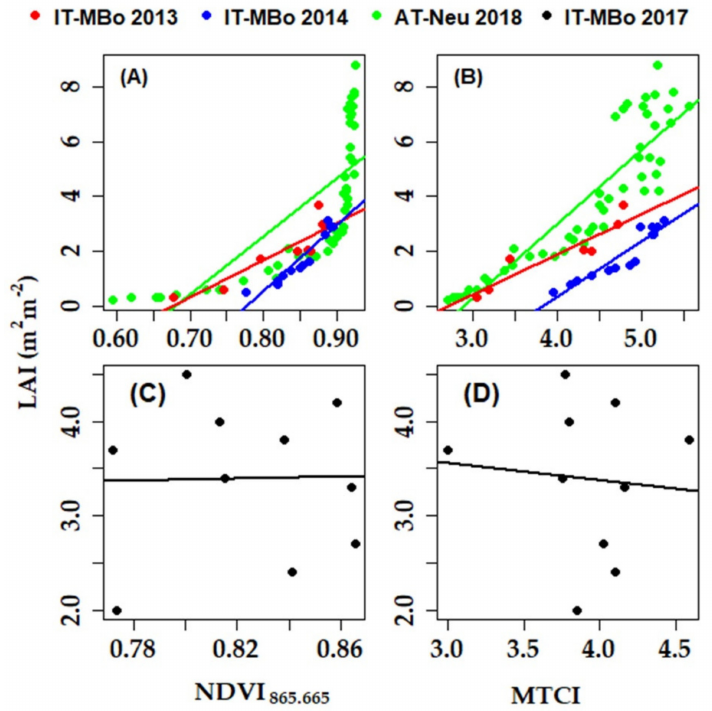
Figure 6. Relationship between VIS-NIR indices and LAI: for temporal observations at IT-MBo (2013 and 2014) and AT-Neu 2018 ( A , B ); and for spatial observations at IT-MBo 2017 ( C , D ). In all panels, solid lines represent a linear fit to the data.